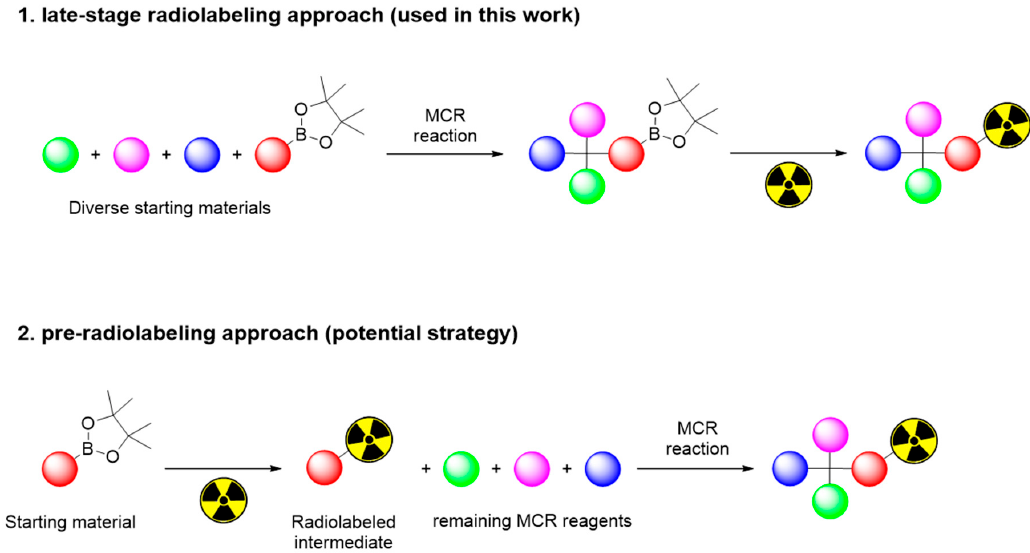
Figure 1. Current and potential multicomponent reaction (MCR) approaches for the generation of scaffold diversity.